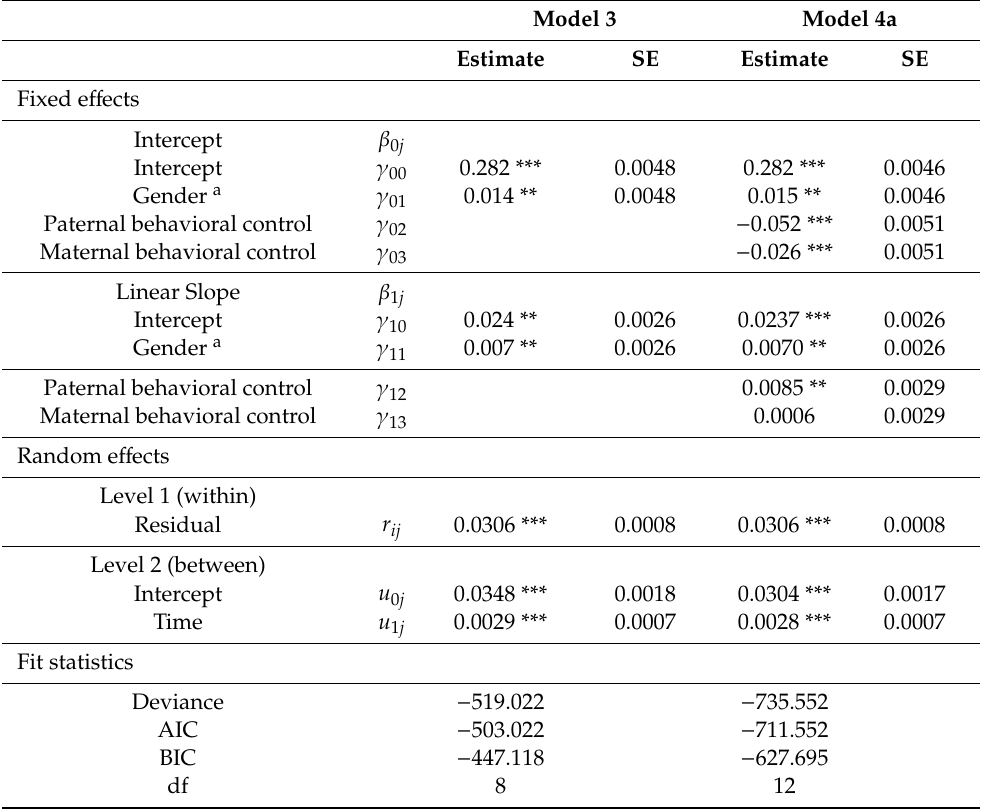
Table 7. Results of IGC models with Level-2 predictors for adolescent delinquency (Waves 1–3).